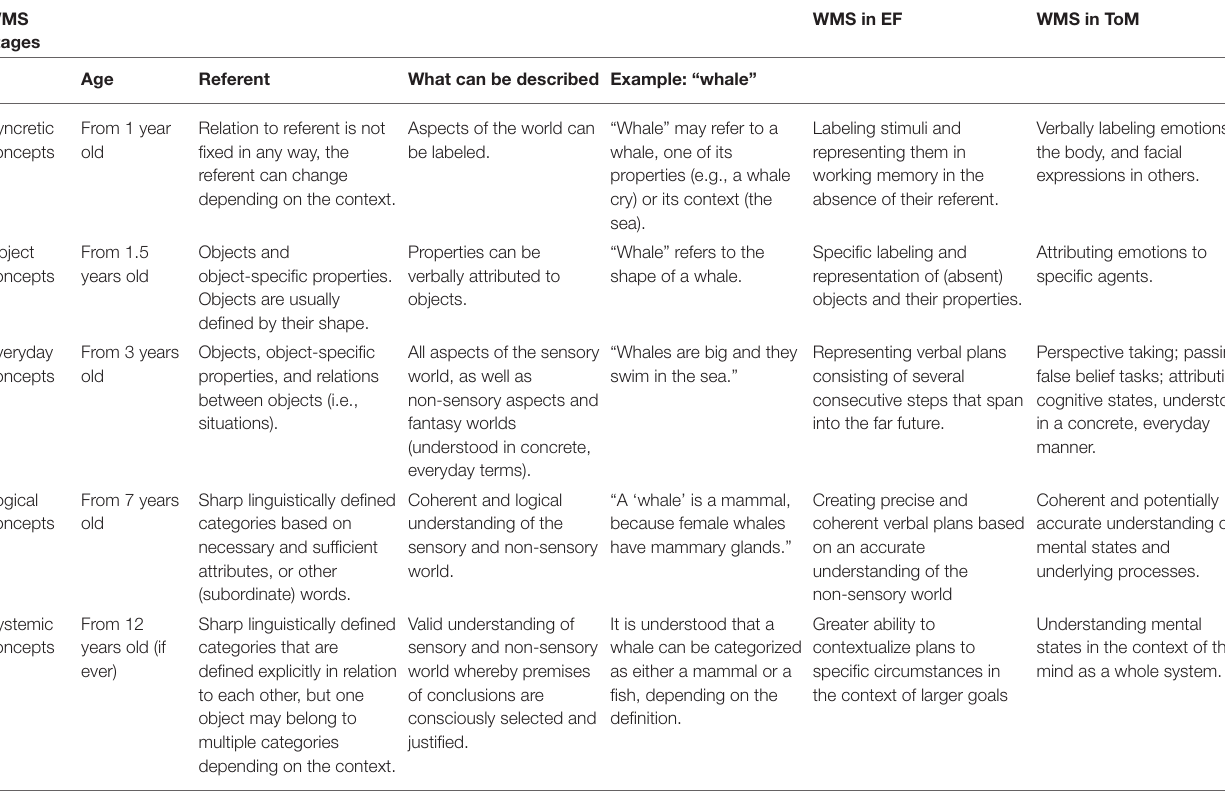
TABLE 1 | Overview of the stages of word meaning structure (WMS) and the development in executive functioning (EF) and theory of mind (ToM) that they allow